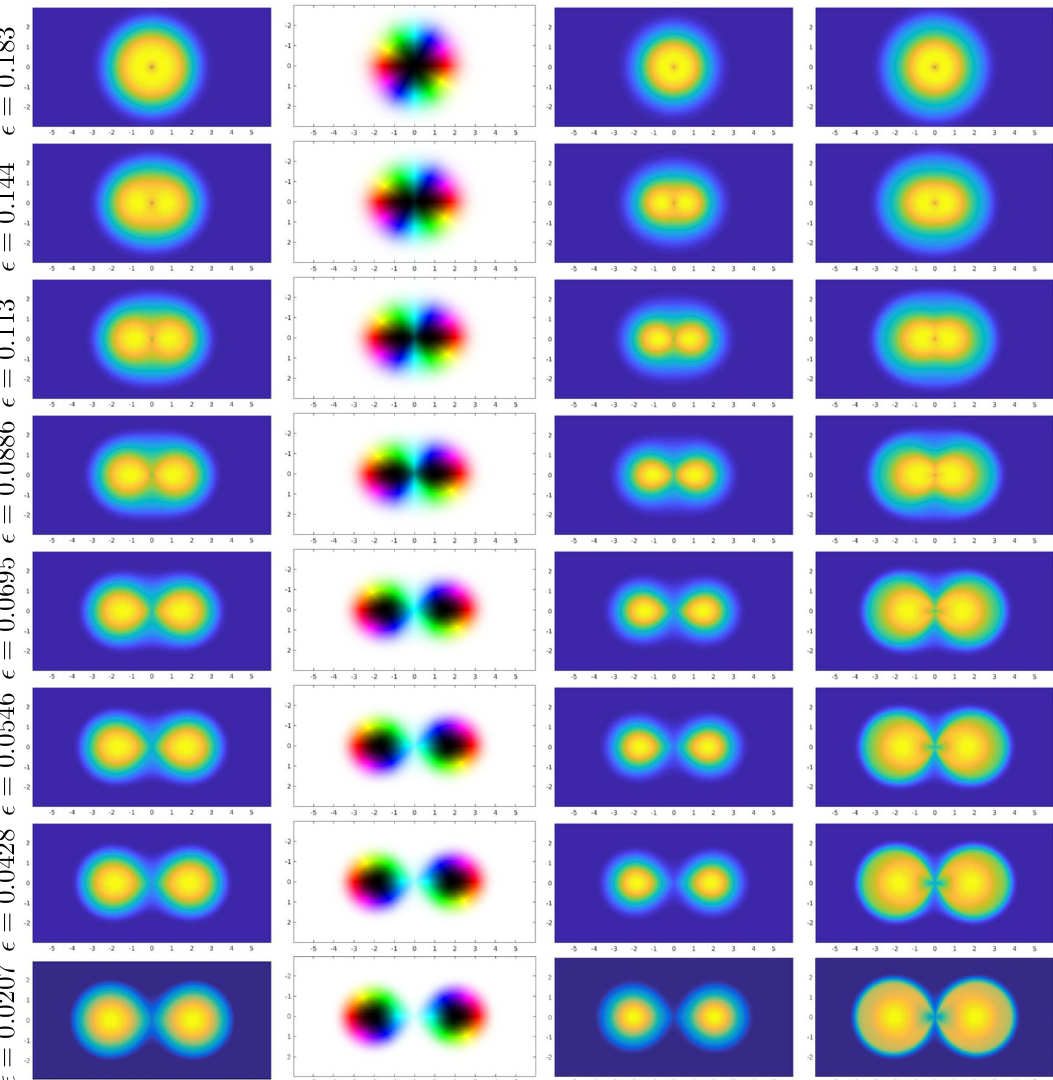
Figure 7 . The Q = 1 + 1 baby-Skyrmion solution as a function of (cid:15) . The columns display the topological charge density, the field orientation using the color scheme described in the text, the total energy and finally the kinetic term − (cid:15) L 2